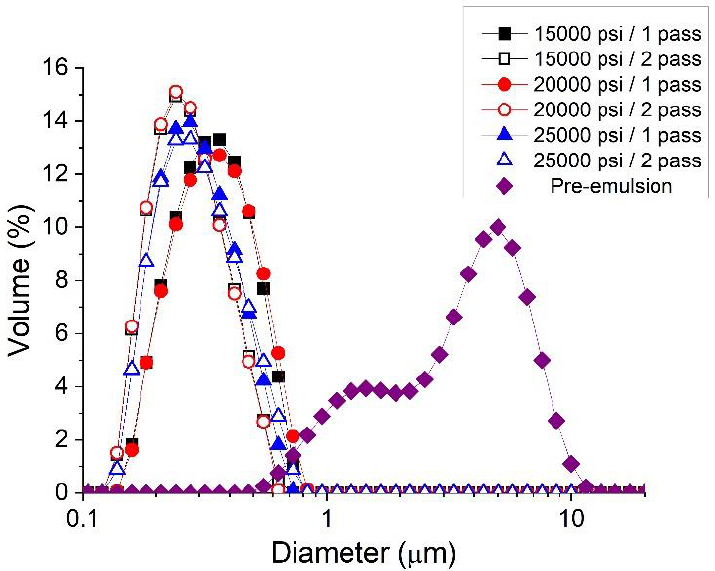
Figure 1. Droplet size distribution for nanoemulsions formulated with 40 wt.% of linseed oil as a function of homogenization pressure and number of passes in the Microfluidizer M110P. Table 1. Sauter diameter, volumetric diameter, D 10 , D 50 , D 90, and span values for linseed oil nanoemulsions as a function of homogenization pressure and number of passes using the Microflu- idizer.